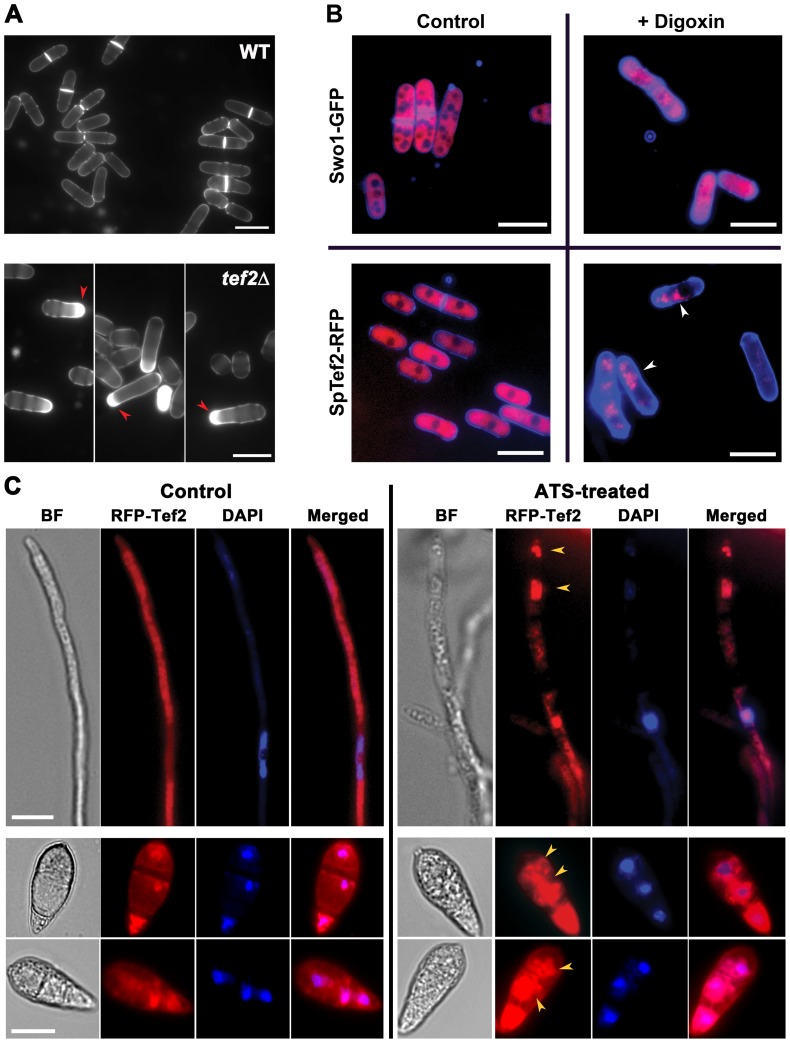
ATS associates with Tef2 in S. pombe and M. oryzae.(A) Loss of SpTef2-function simulates ATS effect in S. pombe. Cell wall staining of the wild-type or tef2Δ S. pombe cells using CFW. Red arrowheads depict defective septal/cell wall deposition. Scale bar equals 10 micron. (B) Effect of digoxin on subcellular localization of SpTef2-RFP or Swo1-GFP in S. pombe cells. The strains expressing the indicated fusion proteins were stained with CFW and analysed by epifluorescence microscopy. Arrowheads show distinct aggregates of SpTef2-RFP. Bar = 10 µm. (C) Effect of ATS on localization of RFP-Tef2 in M. oryzae vegetative hyphae (upper panels; Scale Bar = 5 µm) and conidia (middle and lower panels; Bar represents 10 µm) co-stained with DAPI to aid visualization of nuclei. Arrowheads denote aberrant perinuclear aggregates and/or patches of RFP-Tef2. BF, Bright Field.